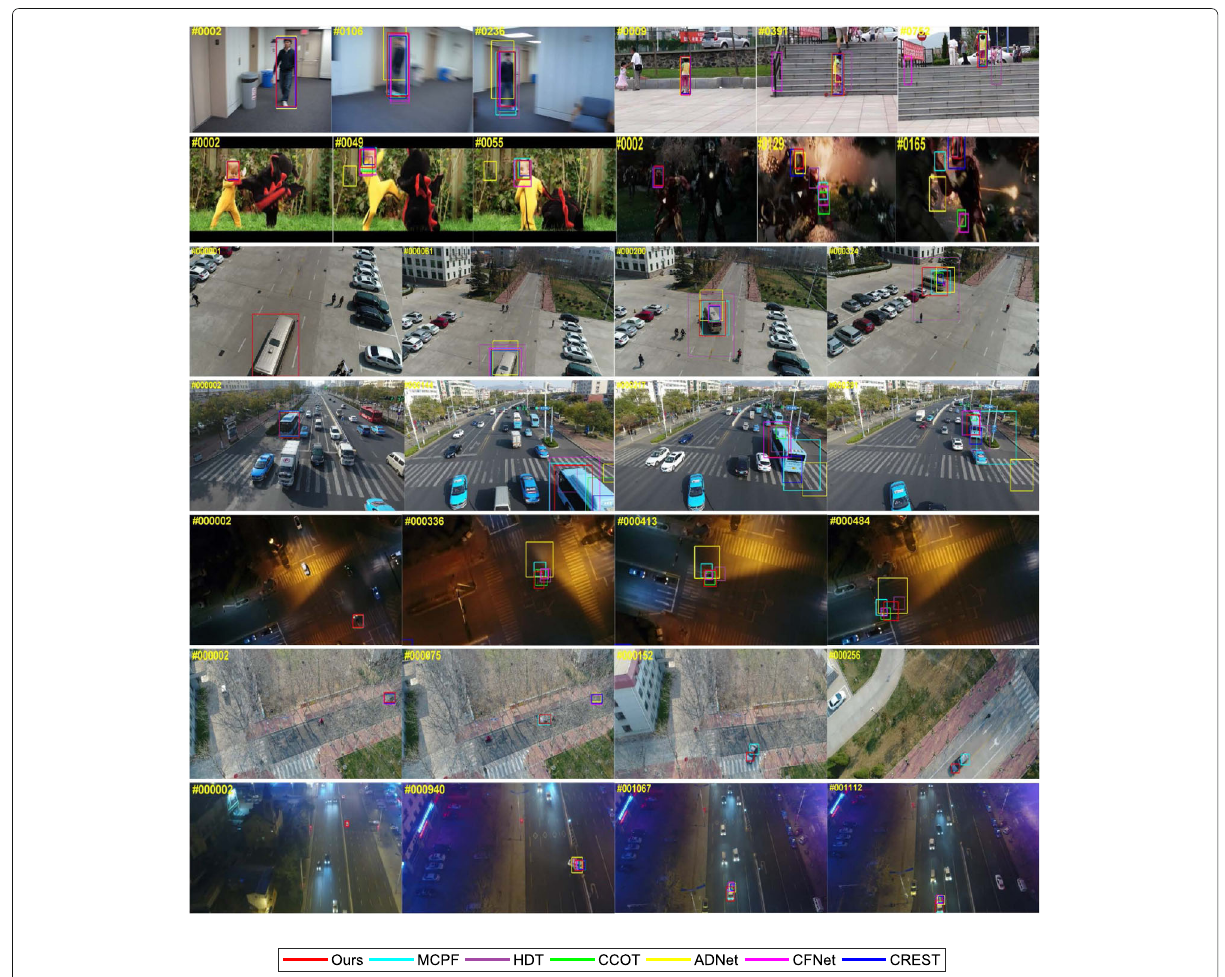
Fig. 7 Several samples of tracking results on both the OTB100 dataset and the UAV dataset (from top to bottom, left to right: BlurBody, Girl2, DragonBaby, Ironman, S1701, S0602, S1301, S0103, and